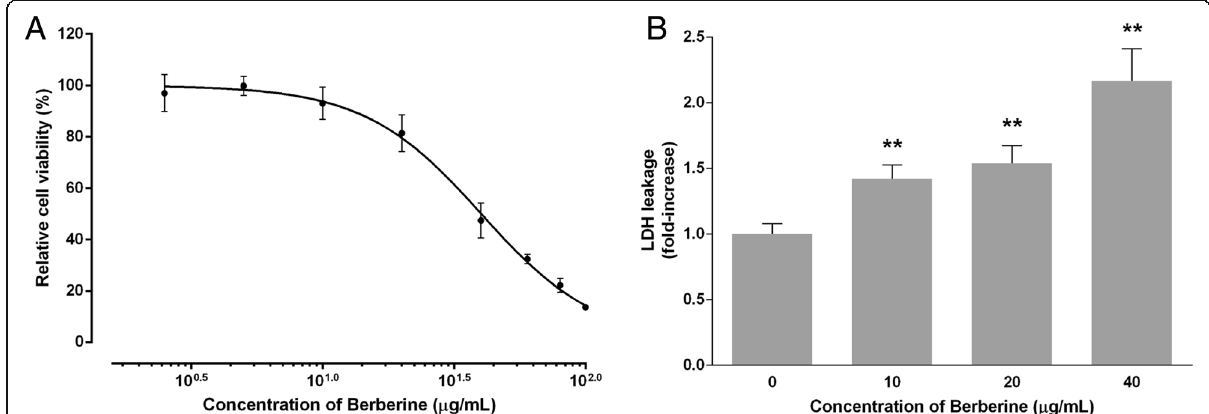
Fig. 1 Effect of BBR on MDA-MB-231 viability and LDH release. Cells were seeded in 96-well plates at 5000 cells per well and treated with various concentrations of BBR for 48 h, the control wells were treated with equivalent amount of medium alone. The effect of BBR on MDA-MB-231 ( a ) viability and ( b ) LDH release was determined by the assays described in the Methods section. The relative cell viability and LDH leakage was calculated as the ratio of the absorbance at 490 nm of each treatment group against those of the corresponding untreated control group. Each value represents the mean ± S.D. ( n = 6) of three independent experiments. * p < 0.05, ** p < 0.01, compared to the control